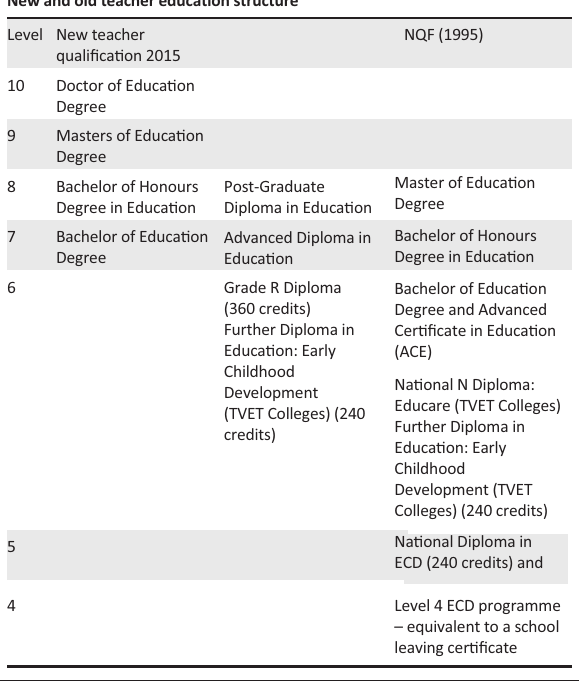
FIGURE 1: The old and new teacher qualification structure in South Africa.